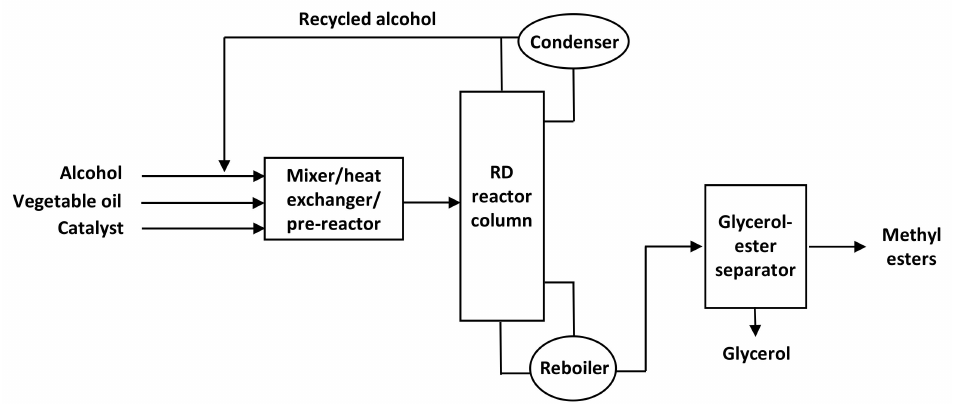
Figure 13. Closed-loop static mixer reactor.